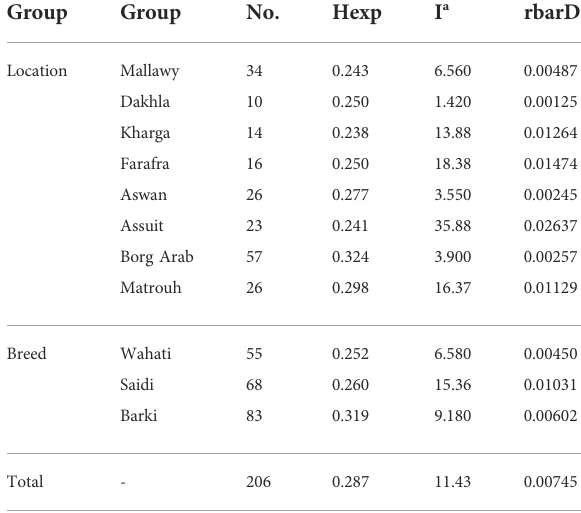
TABLE 2 The diversity statistics analysis, genetic richness, and evenness using Hexp Nei ’ s unbiased gene diversity (Nei, 1978), the index of association (Ia) (Agapow and Burt, 2001), and the standardized index of association (rbarD) (Brown et al., 1980).